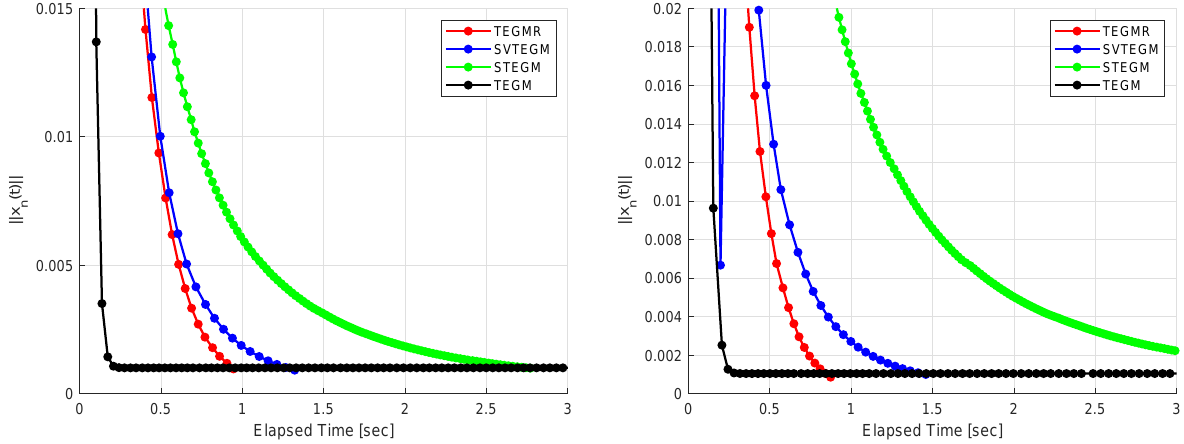
Figure 4. Example 4, ( left ): Case III and ( right ): Case